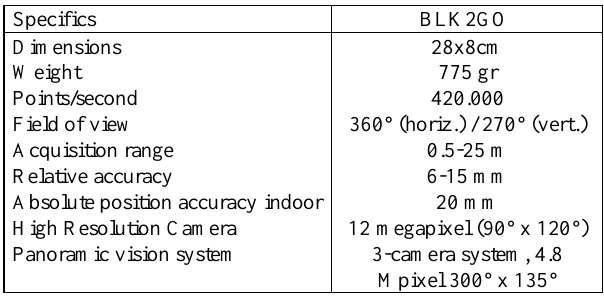
Table 1 . BLK2GO main specifications